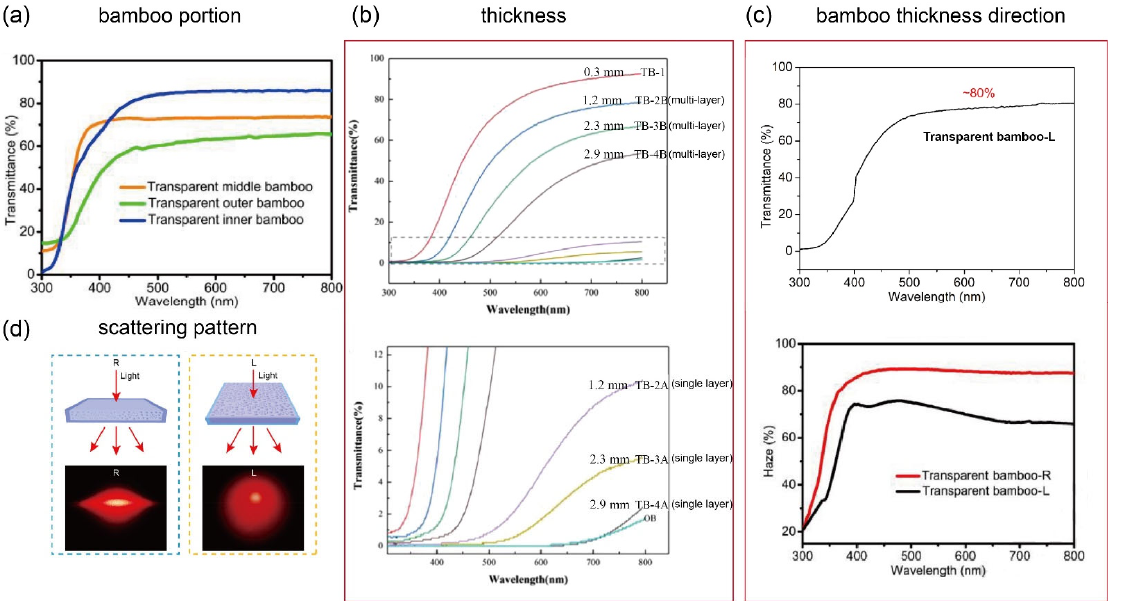
Figure 3. Transmittance and haze data for TB according to ( a ) bamboo fiber location [35], ( b ) bamboo thickness [24], and ( c ) bamboo thickness direction [35], as well as the ( d ) scattering pattern of TB according to bamboo thickness direction (anisotropy effect) [35]. (( a , c , d ) Adapted from Wang et al. [35]; ( b ) Adapted from Wu et al. [24]). Table 1. Summary of TB preparations and properties.